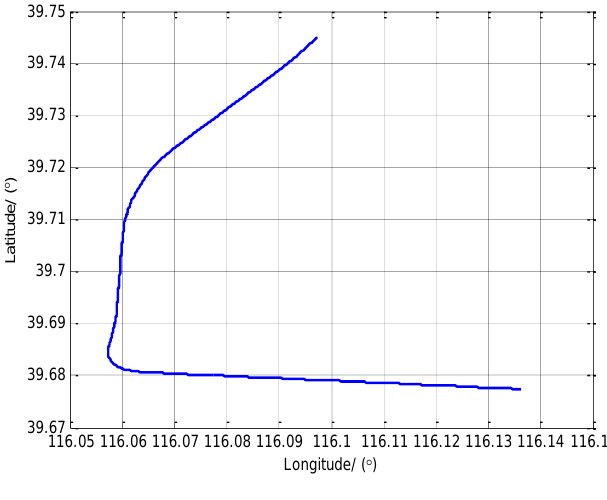
Figure 3. The trajectory of vehicle experiment.